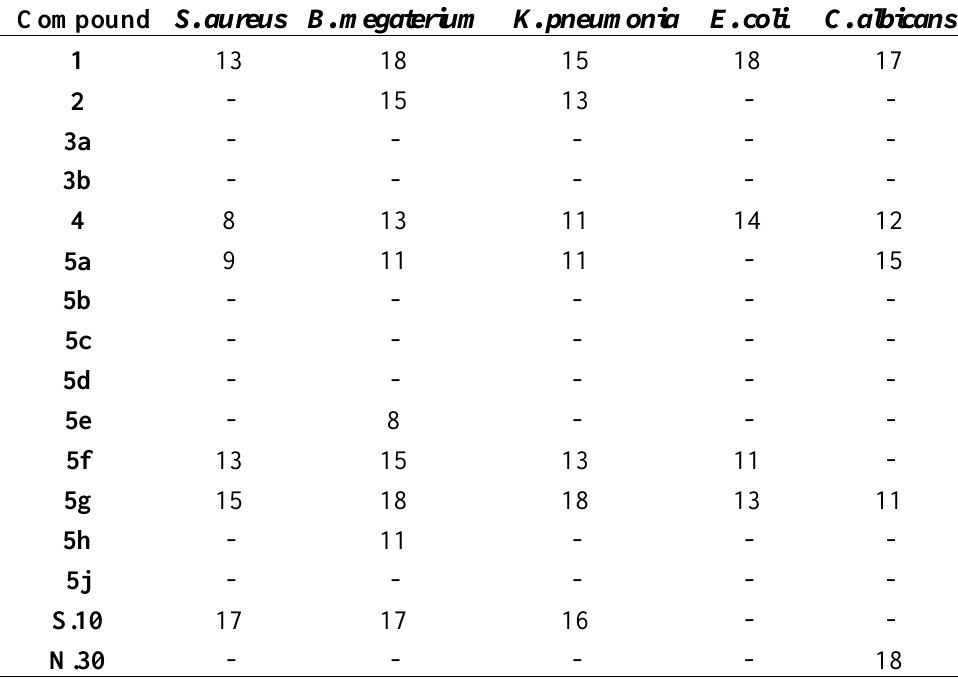
Table 1 Antimicrobial effect of the compounds* Compound S. aureus B.